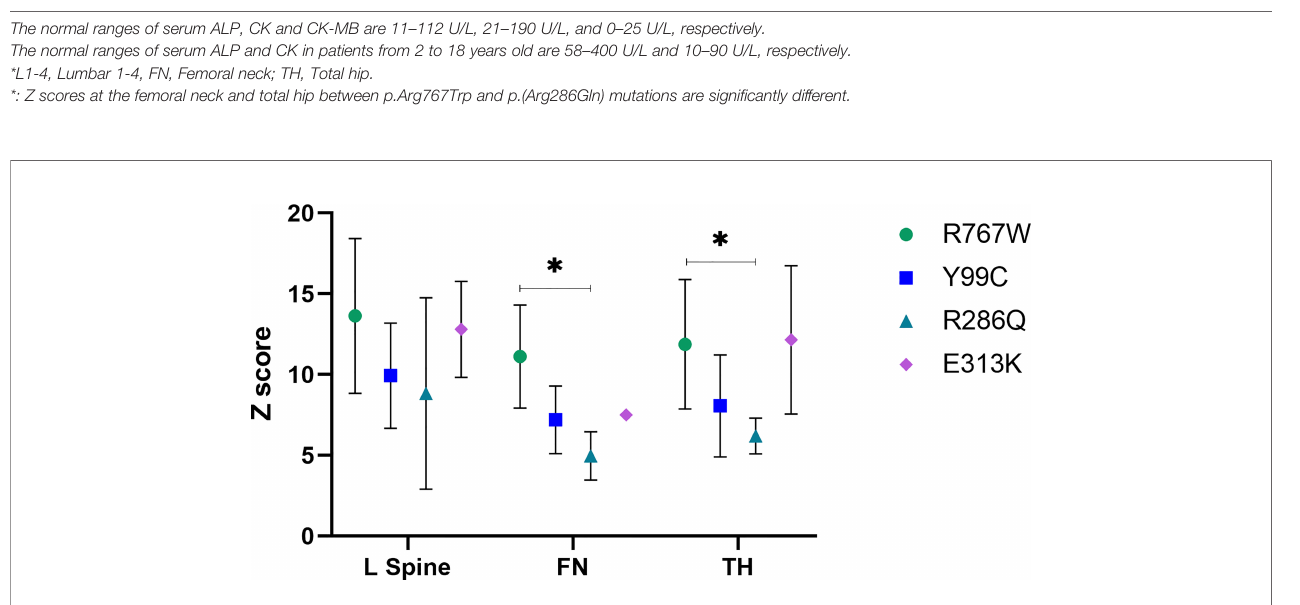
The normal ranges of serum ALP, CK and CK-MB are 11 – 112 U/L, 21 – 190 U/L, and 0 – 25 U/L, respectively. The normal ranges of serum ALP and CK in patients from 2 to 18 years old are 58 – 400 U/L and 10 – 90 U/L, respectively.